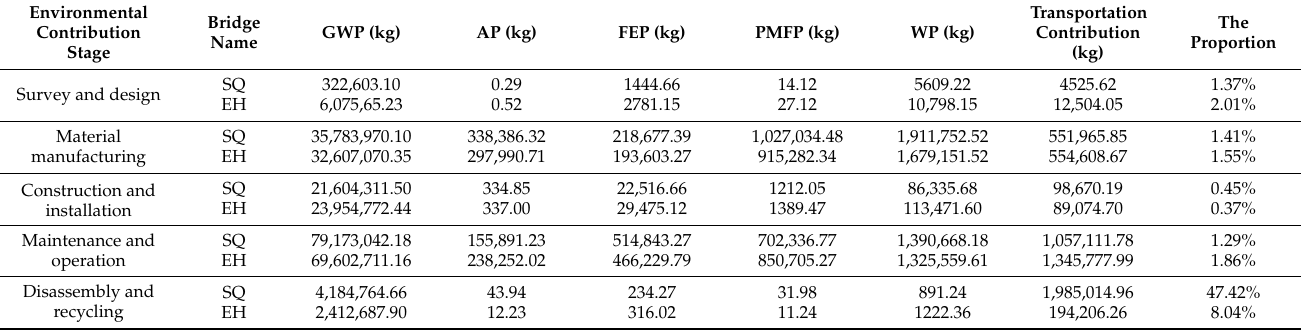
Table 5. Summary table of bridge environmental impact contributions (Table 4 formula